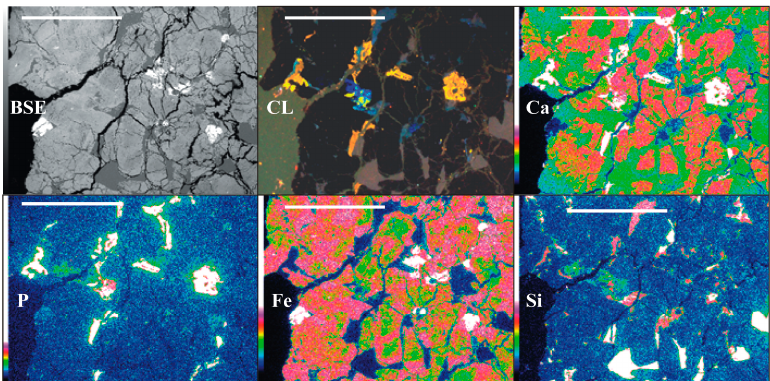
Figure 1. The thin section: backscattered electrons (BSE) and cathodoluminescence (CL) images and the elemental maps. The rock is mainly composed of zoned pyroxenes (cores enriched in Ca, rims enriched in Fe; no luminescence), maskelynite and glass (Si distribution; blue, dull-violet luminescence) and Ca-phosphates (dull-orange luminescence). Scale bar-1 mm.